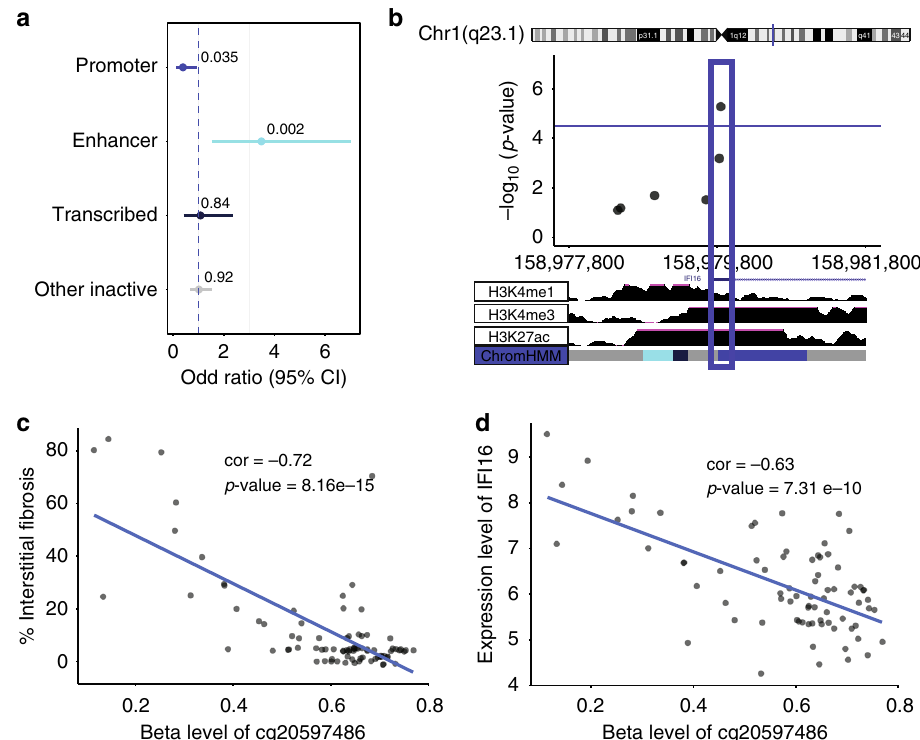
Fig. 3 Functional annotation of methylation probes associated with interstitial fi brosis. a Probes signi fi cantly associated with fi brosis were annotated by their regulatory region location. Odds ratios and signi fi cance was calculated based on all array probes used in the regression analysis ( n = 321,473). Probe locations where methylation level is associated with fi brosis were enriched on kidney enhancer regions OR = 3.49 (95%CI 1.53 – 7.04, p -value = 0.002) using a two-sided fi sher exact test. Blue dashed line indicates OR = 1. b Locus zoom for one top replicated methylation probe (cg20597486) associated with interstitial fi brosis located in kidney promoter region. Chromosome and track images are from UCSC genome browser build hg19 (http://genome. ucsc.edu). c Methylation probe (cg20597486) associated with interstitial fi brosis in the primary data set using Pearson correlation test. Unadjusted correlation = -0.72 ( p -value = 8.16 e − 15). d Methylation probe (cg20597486) associated with IFI16 gene expression using Pearson correlation test. Unadjusted correlation = -0.63 ( p -value = 7.31 e − 10)